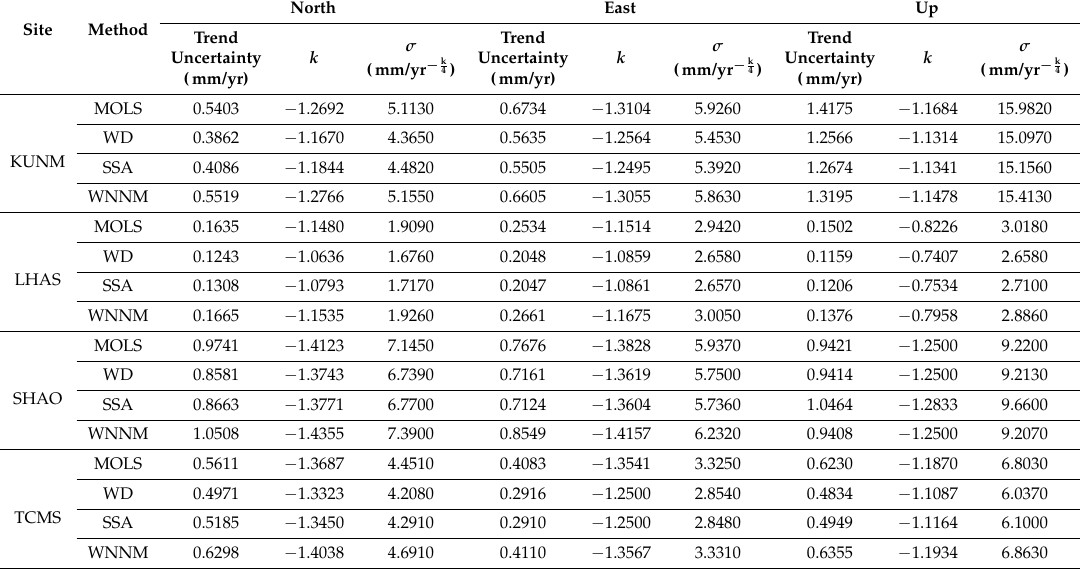
Table 8. Results of trend uncertainty, spectral index and noise amplitude estimated from the GNSS time series of the other stations under different